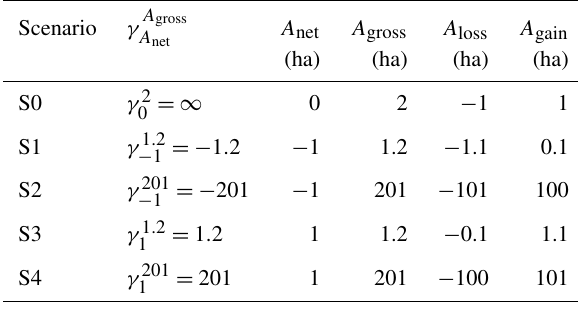
Table 1. Illustrative scenarios with different ratios of gross to net forest area changes impacting legacy LULCC emissions after a pulse disturbance of forest area at t = 0. A net , A gross , A loss , A gain A gross and γ are the applied net forest area change, gross forest area A net change, gross forest loss area, gross forest gain area and the ratio of A gross to A net at t = 0. A positive value of an area change is an increase in forest area.